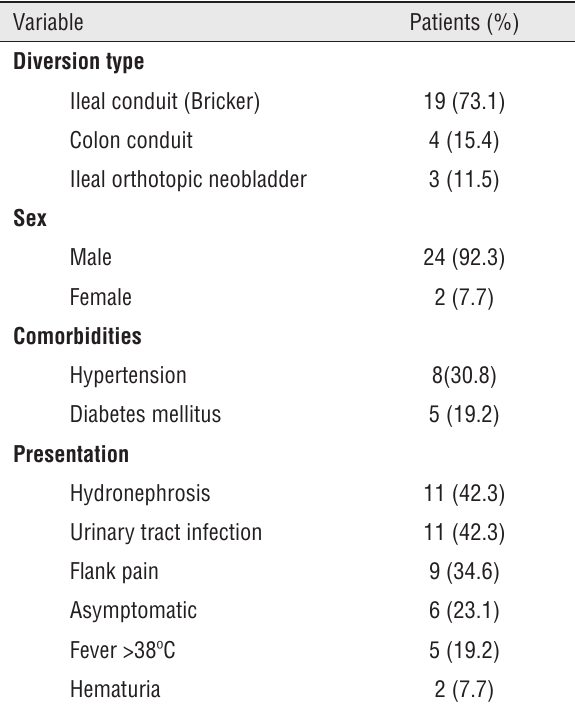
Table 1 - Diversion type and Patients’ demographics